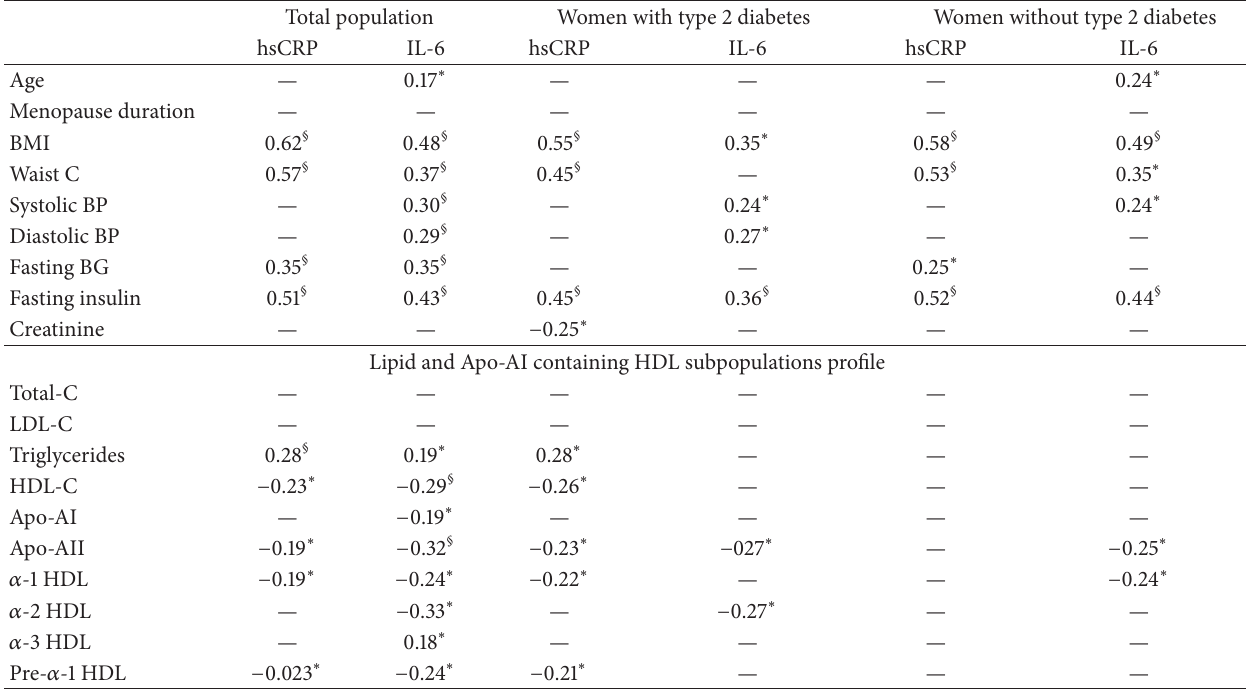
Table 2: Correlation coefficients ( 𝑟 𝑆 ) between markers of systemic inflammation and metabolic, lipid, and Apo-AI containing HDL subpopulations profile in women with and without type 2 diabetes.